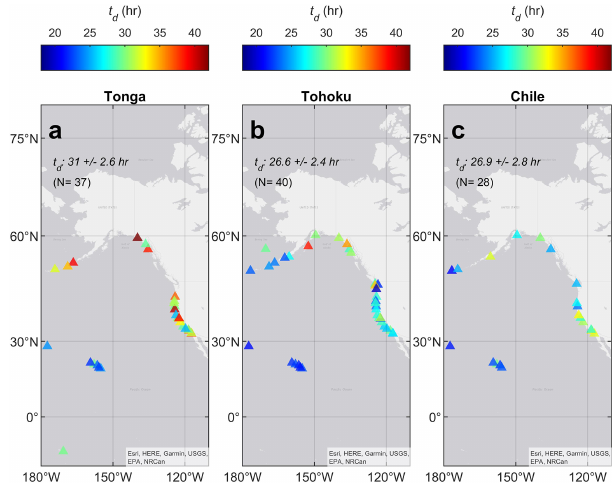
Figure 7. Decay timescales (hours) of recent tsunami events at NOAA gauges in the northern Pacific, showing (a) Tonga, (b) To- hoku, and (c) Chile. Median t d , errors, and number of stations used are given in each panel.